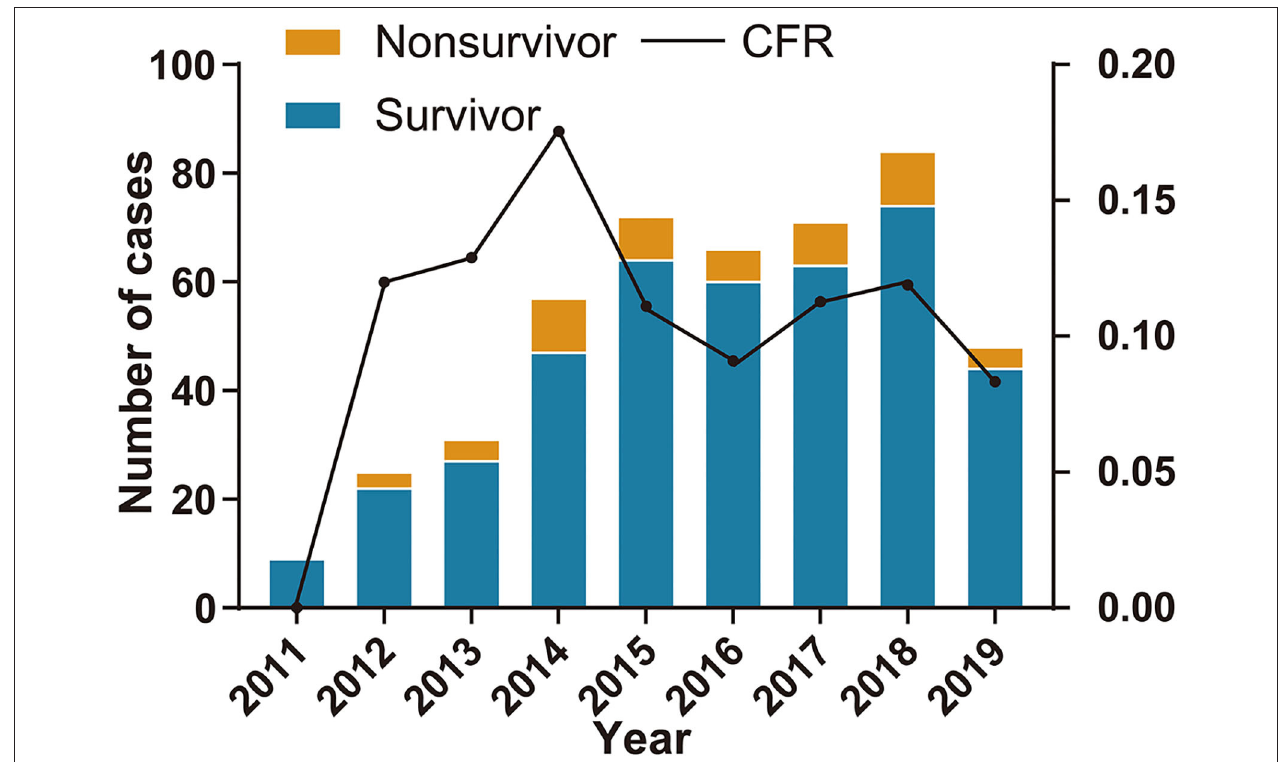
FIGURE 2 | The number of severe fever with thrombocytopenia syndrome (SFTS) cases and case fatality rate in Zhejiang Province from 2011 to 2019.